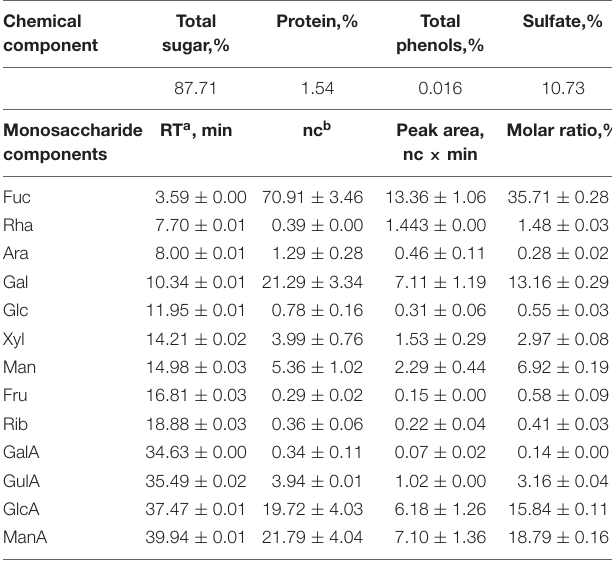
TABLE 1 | The monosaccharide components of polysaccharides (PSs) fractionated from Laminaria japonica polysaccharides (LJPS). Chemical